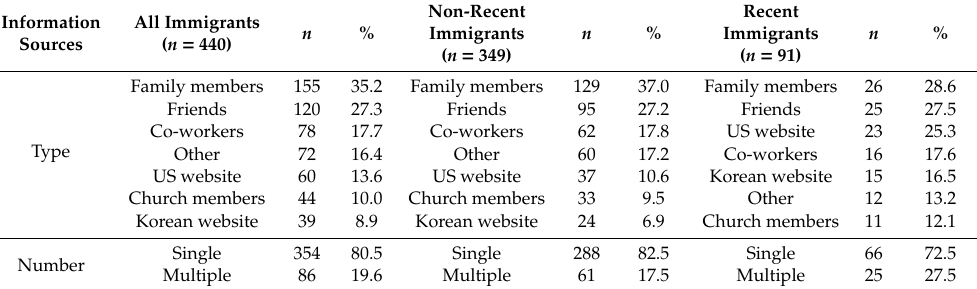
Table 2. Information sources of Korean immigrants’ search for doctors in the